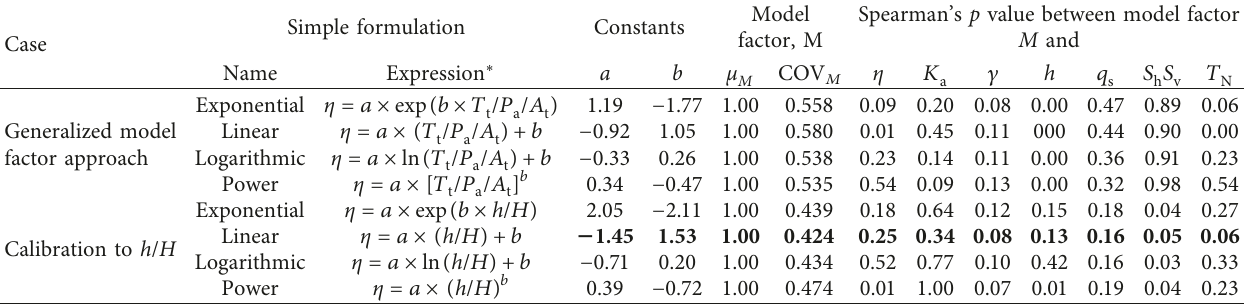
f T P A t / a / t ) and η (cid:31) (cid:31) (